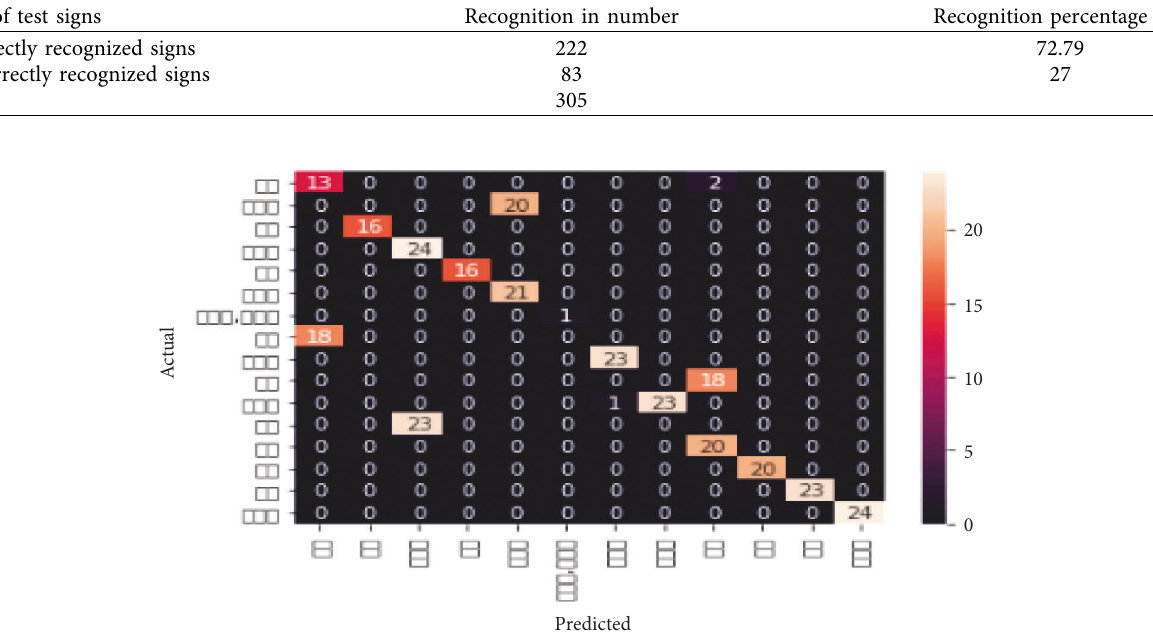
Figure 12: Confusion matrix for developed recognition